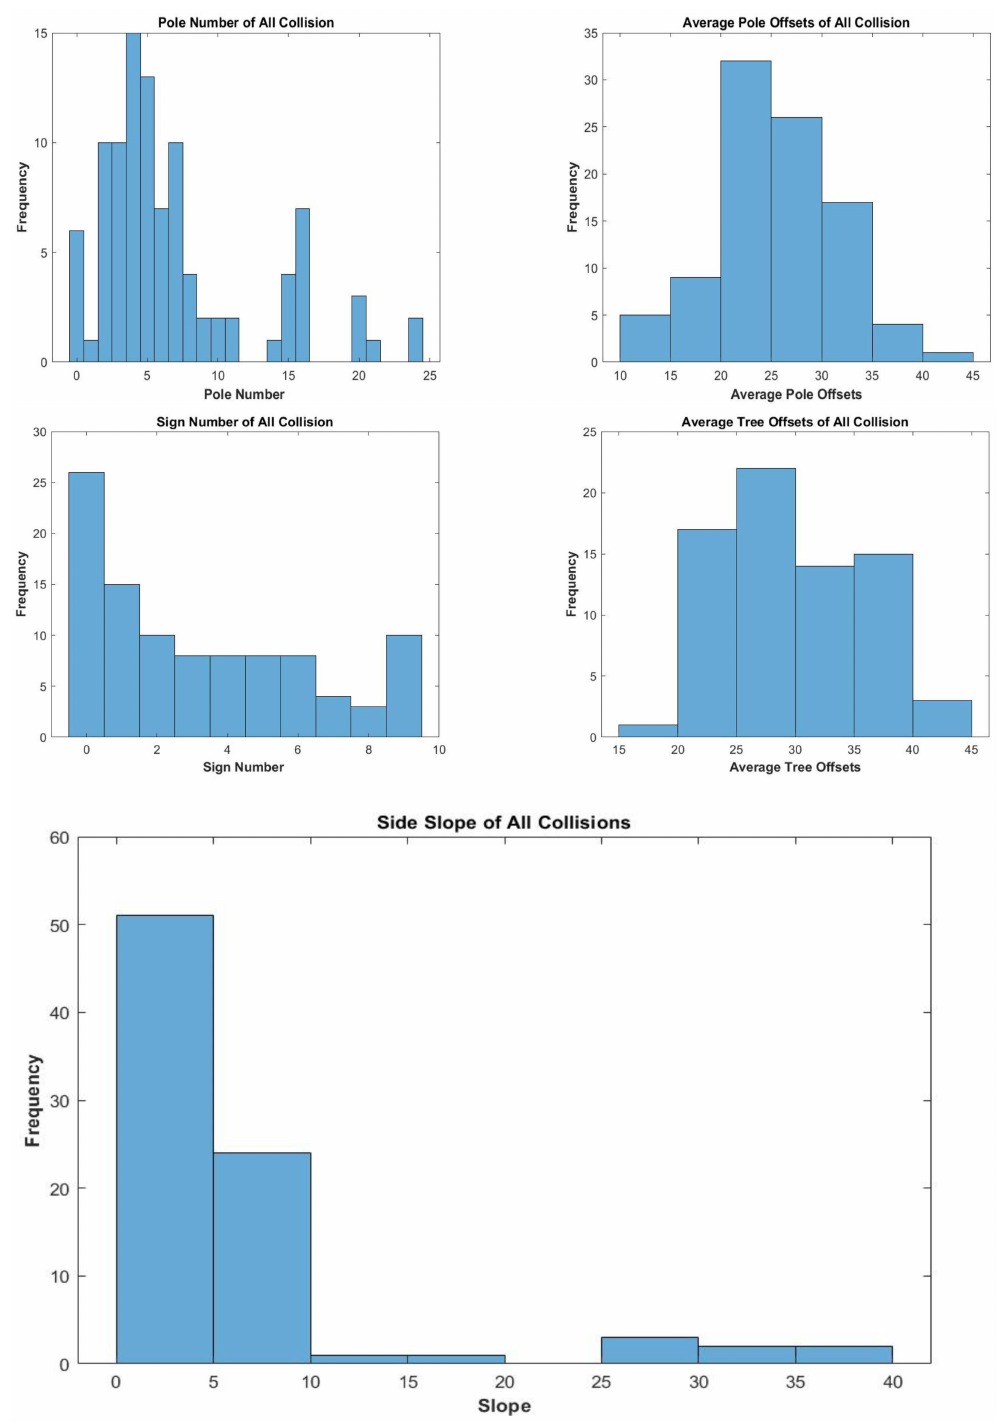
Figure 7. Variability in extracted features across different collision